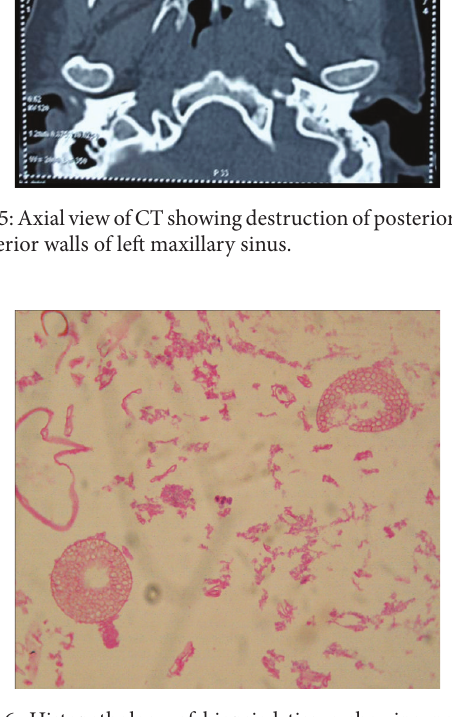
Figure 6: Histopathology of biopsied tissue showing nonseptate obtuse angled fungal hyphae and sporangiophores with